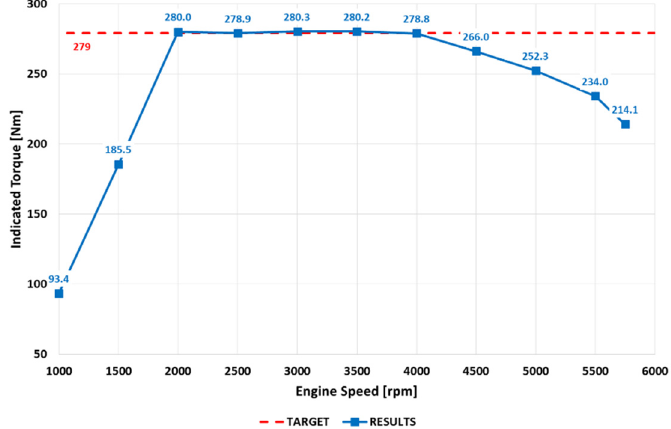
Figure 8. The predicted engine indicated torque.